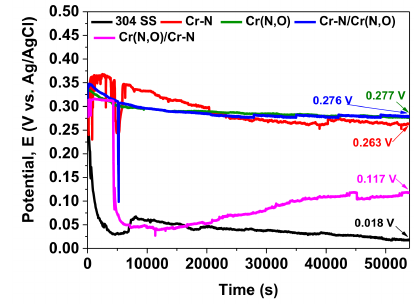
Figure 7. Open circuit potential evolution of Cr-based coatings deposited on 304